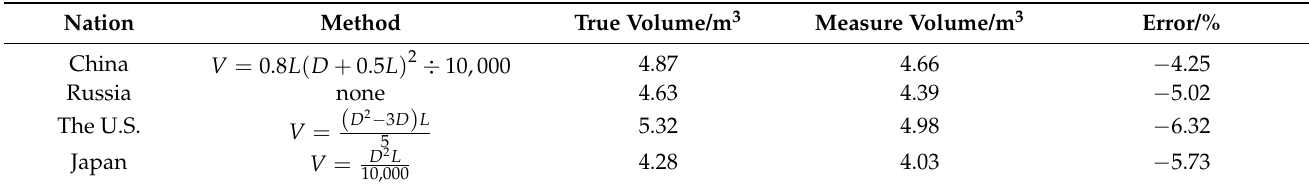
Table 8. Comparison of Volume Calculations Using Standards from Different